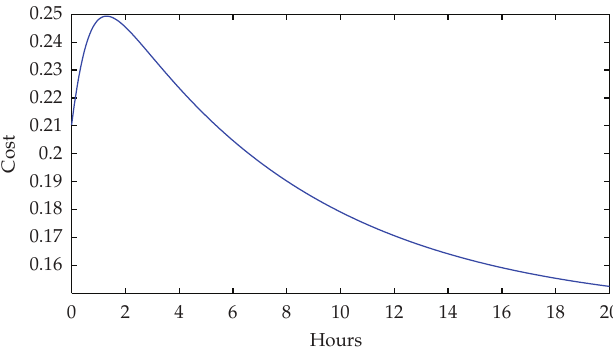
Figure 3: The optimal value of the cost of both the